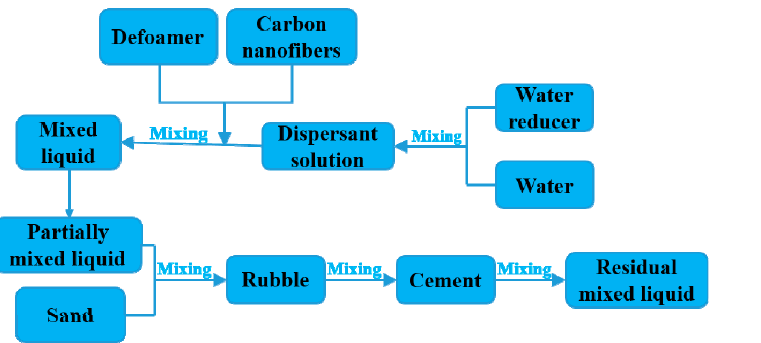
Figure 1. The preparation process of carbon nanofiber reinforced concrete (CNFC) group mixture.